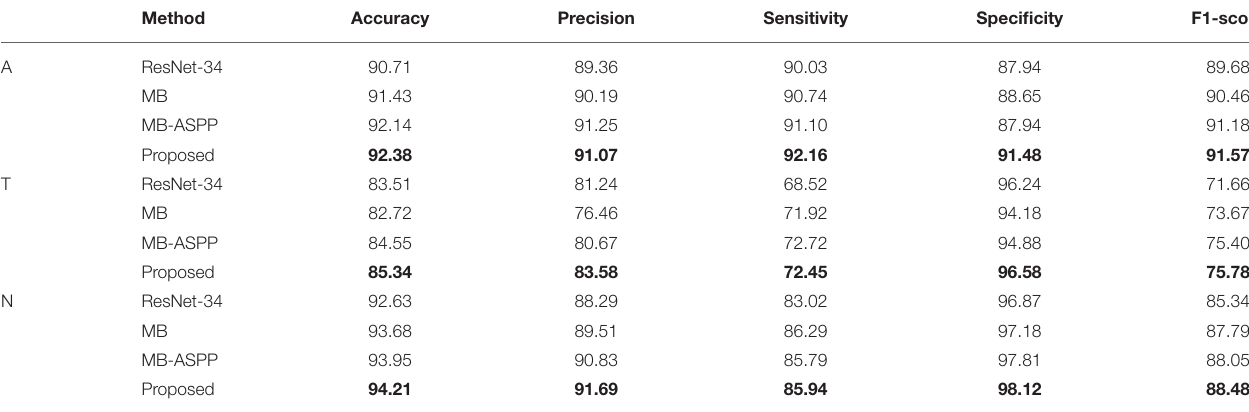
TABLE 3 | Comparison of different methods in the testing dataset